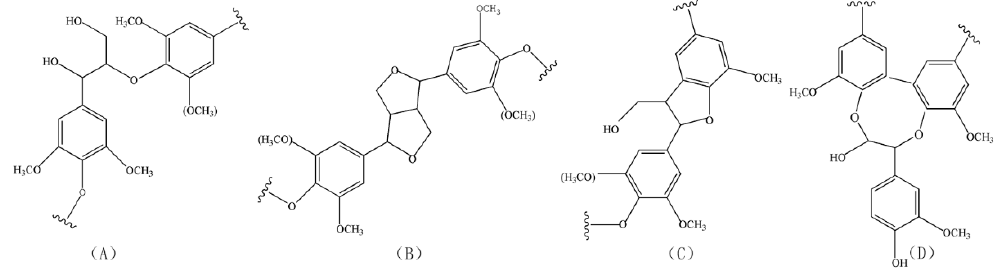
Figure 4. Main substructures of lignin inside the jute fibers: ( A ) β-O-4 aryl ether linkages with a free OH at the γ-carbon ( B ) resinol substructures formed by β-β, α-O-γ and γ-O-α linkages; ( C ) phenylcoumarane substructures formed by β-5 and α-O-4 linkages; ( D ) 5-5′-O-4 linkages.